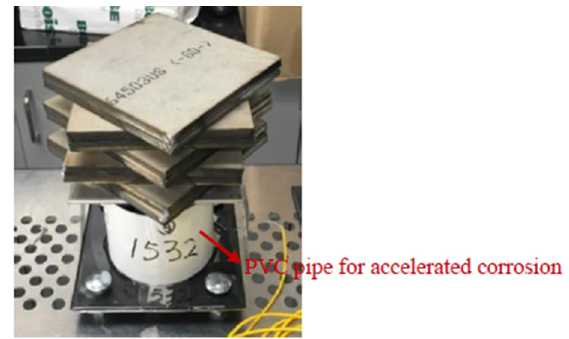
Figure 9. Experimental setup for corrosion-only tests: ( a ) corrosion-only test setup and ( b ) introduc- ing artificial cracks on epoxy coating for accelerated localized corrosion.